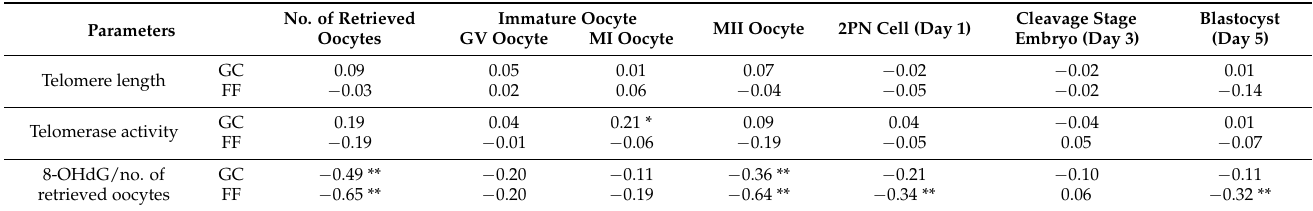
Table 10. The association between indicators of IVF success and telomere length, telomerase activity and 8-OHdG levels in granulosa cells and follicular